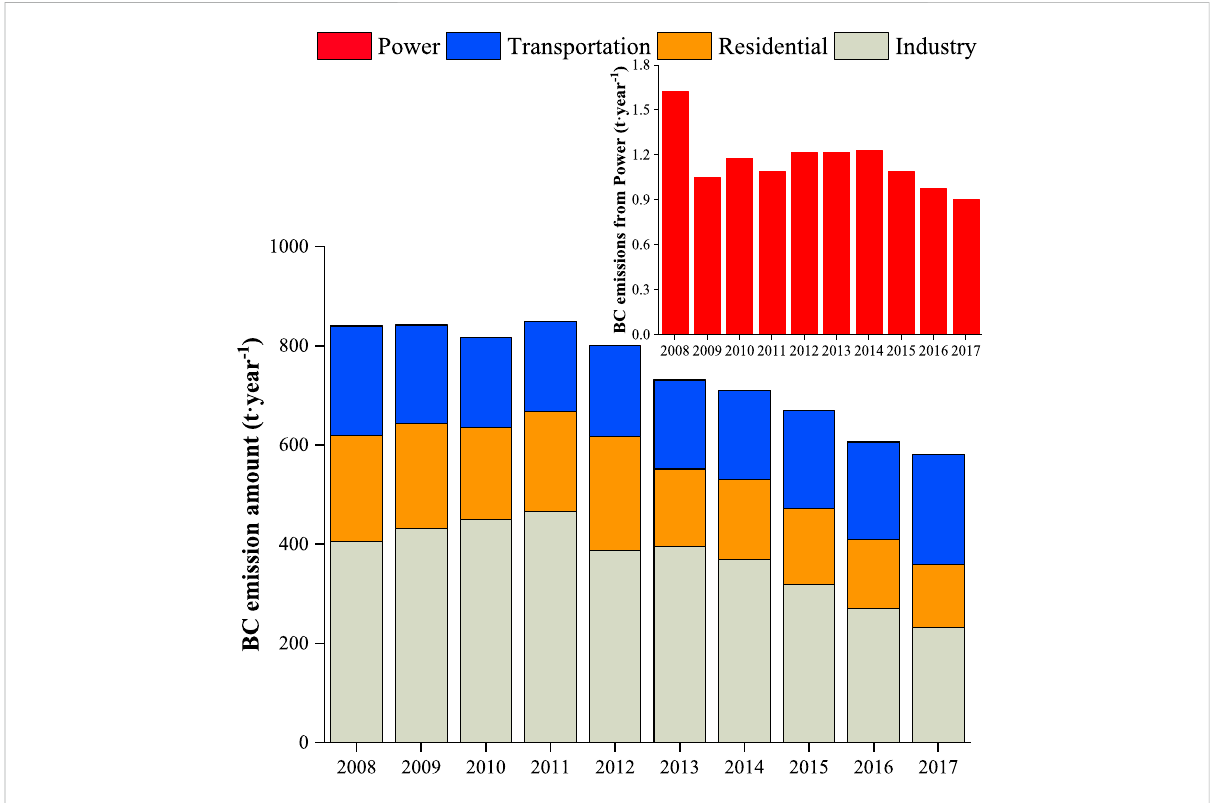
FIGURE 4 Annual emissions from different sources in Zhengzhou based on the 2008 – 2017 MEIC emission